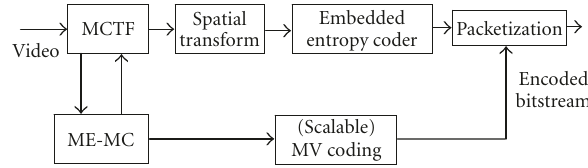
Figure 1: General structure of an MCTF-based fully scalable video